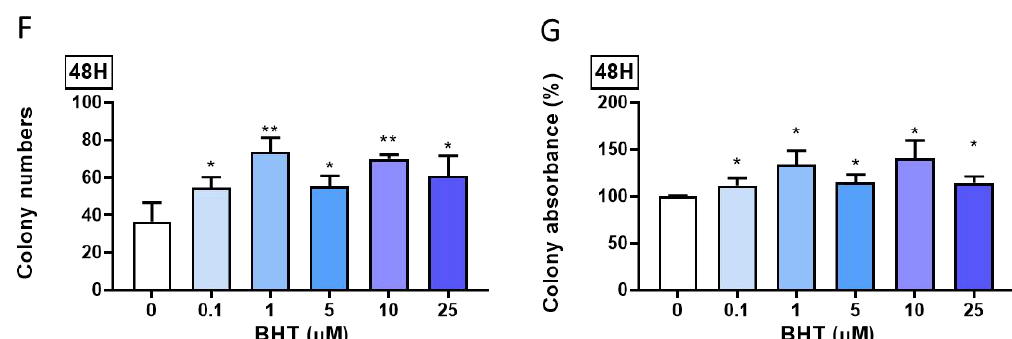
Figure 1. Butylated hydroxytoluene (BHT) effects on leiomyoma proliferation. ELT-3 cells were cultured in a 96-well plate (3000 cells/well) after starvation with a serum-free medium for 24 h. They were then treated with different concentrations of BHT for 24 and 48 h, and we performed the following assays: ( A ) MTT assay to evaluate the cell viability for 24 h and ( B ) 48 h, used doubling time formula to calculate the ( C ) doubling time and Western blot for ( D ) proliferating cell nuclear antigen (PCNA) expression; ( E ) colony formation assay, following culturing in a 6-well plate for the analysis of the long-term effect of different concentrations of BHT; ( F ) graphical representation of colony numbers and ( G ) absorbance percentage following BHT exposure at different concentrations. ImageJ was used to determine the colony number. *, p < 0.05; **, p < 0.01; and ***, p < 0.001, compared with the control group. Doubling time = duration ∗ log (2) / (log (final concentration) −log (initial concentration)).